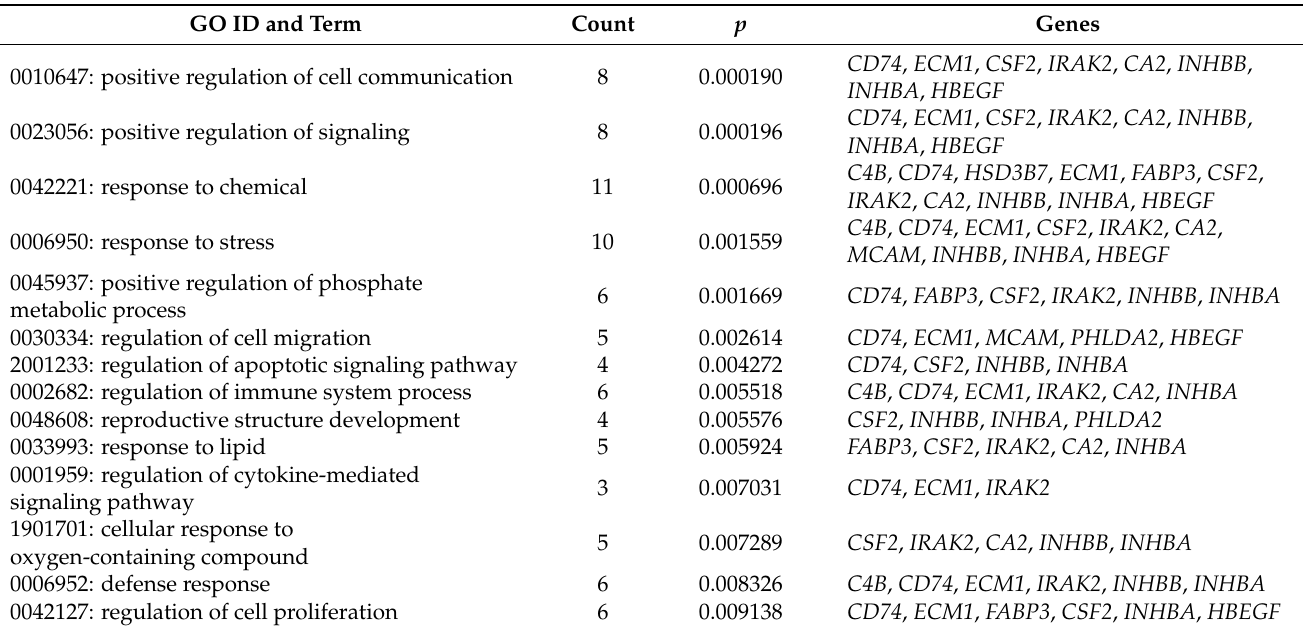
Table 2. Clinicopathological features of 172 oral cancer patients according to the expression level of IRAK2.